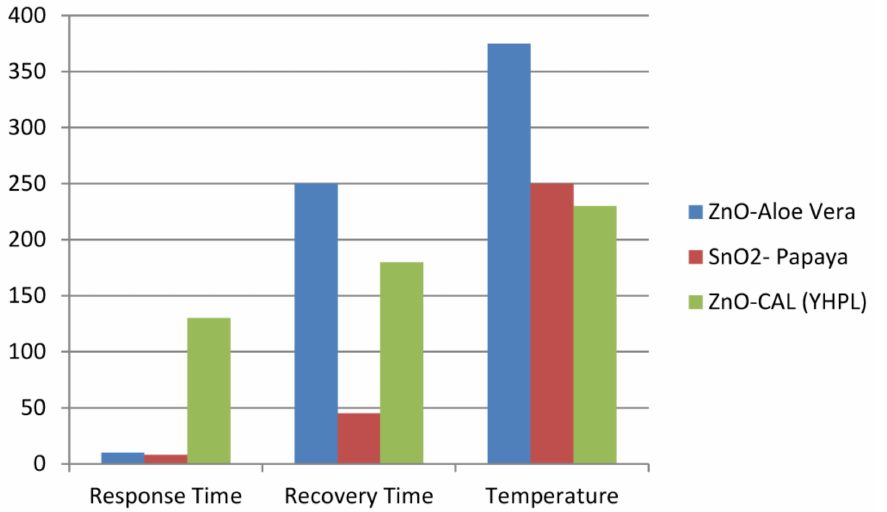
Figure 13. Comparison of response/recovery time (in second) and temperature (in ◦ C) for ZnO-Aloe vera, SnO 2 -Papaya, and ZnO-CAL (YHPL). Reprinted from Ref. [86] with permission of Emerald Publishing Ltd.,